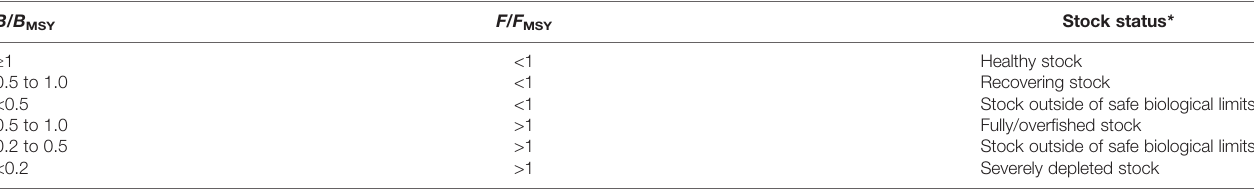
Stock status* from Froese et al.